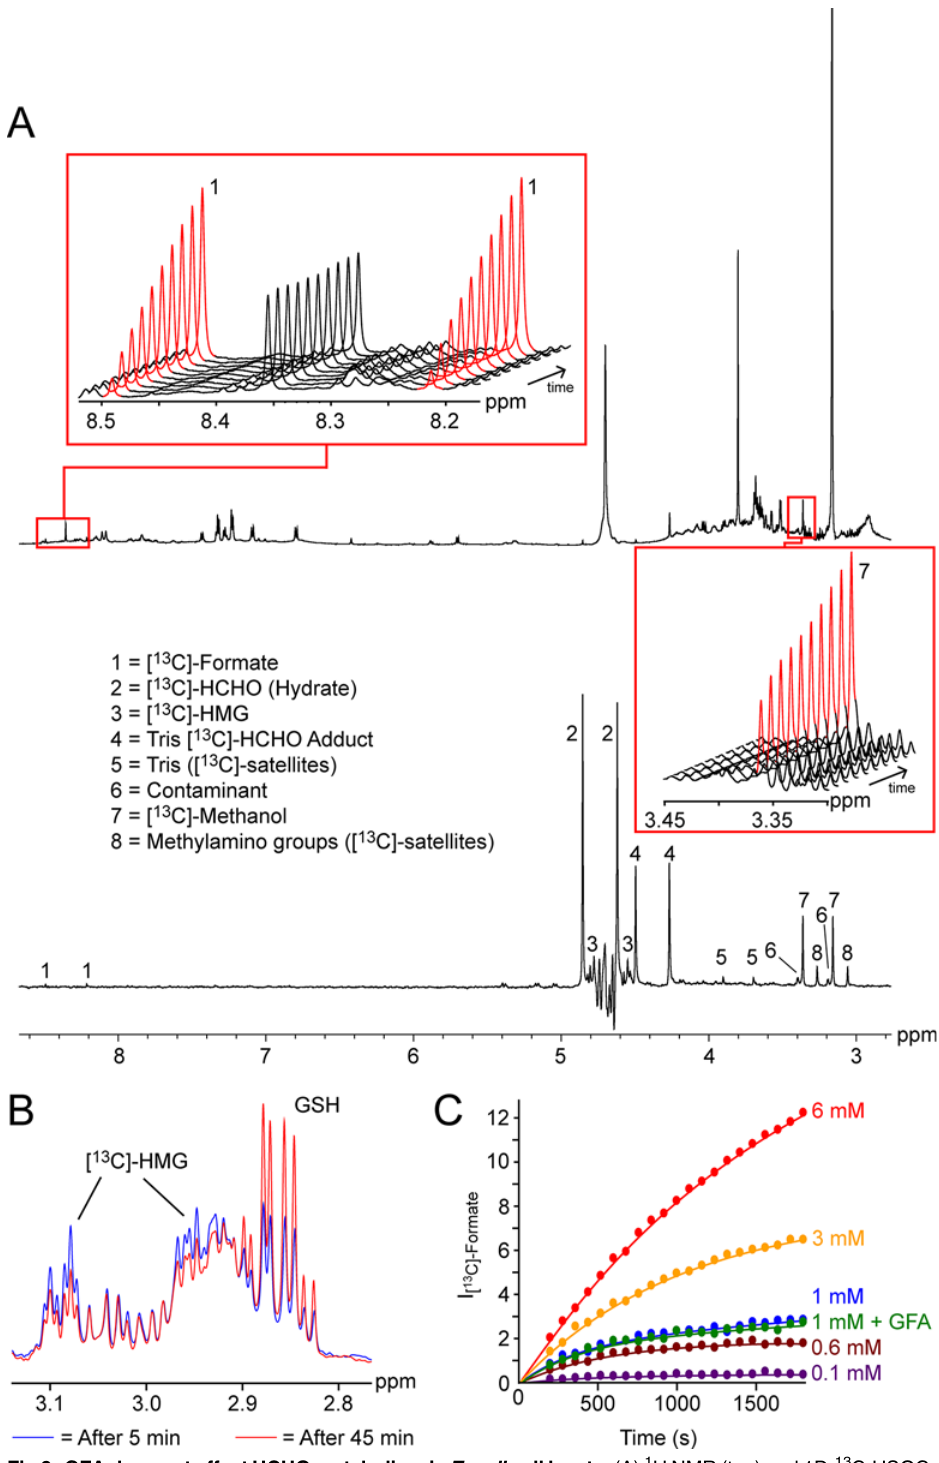
Fig 3. GFA does not affect HCHO metabolism in E . coli cell lysate. (A) 1 H NMR (top) and 1D- 13 C-HSQC spectra (bottom) of E . coli BL21 (DE3) cell lysate (0.5 mg/mL in 50 mM Tris buffer pH 7.5) incubated with [ 13 C]-HCHO (6 mM). Resonances in the 1D-HSQC spectra are annotated. [ 13 C]-satellites for the Tris buffer are observed in the 1D-HSQC spectrum due to its high abundance of in the mixture. The doublet resonance at δ H 3.25 ppm is assigned to methylamino groups from the lysate. Inset top left and bottom right: 1 H